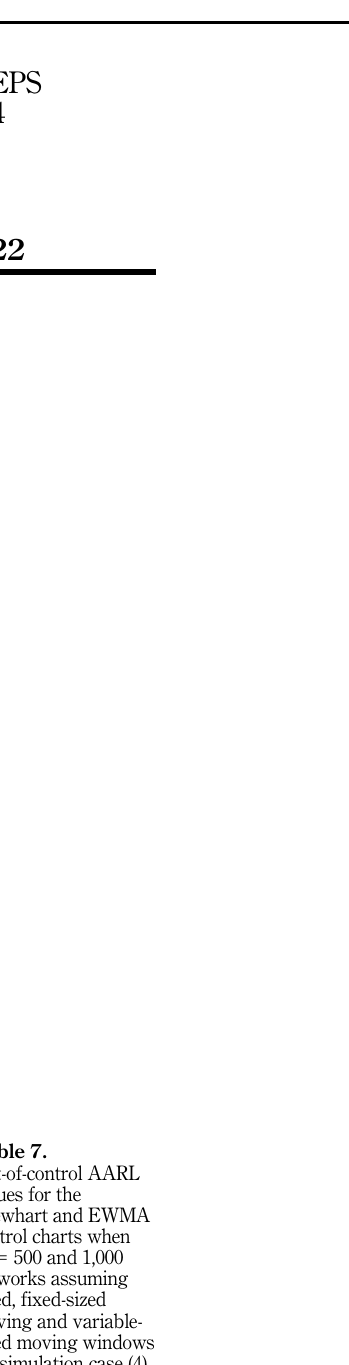
Table 7. Out-of-control AARL values for the Shewhart and EWMA control charts when m 5 500 and 1,000 networks assuming fixed, fixed-sized moving and variable- sized moving windows for simulation case